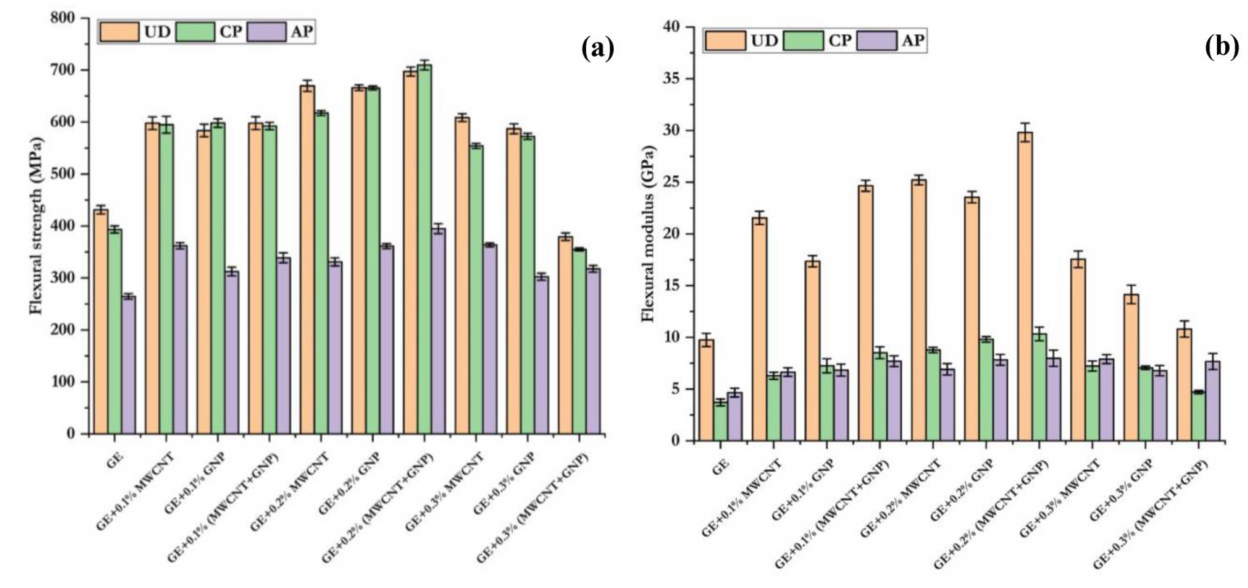
Figure 11. Flexural properties of UD, CP, and AP composites: ( a ) flexural strength and ( b ) flexu- ral modulus. Table 4. Flexural properties of neat and nanofillers reinforced UD, CP, and AP